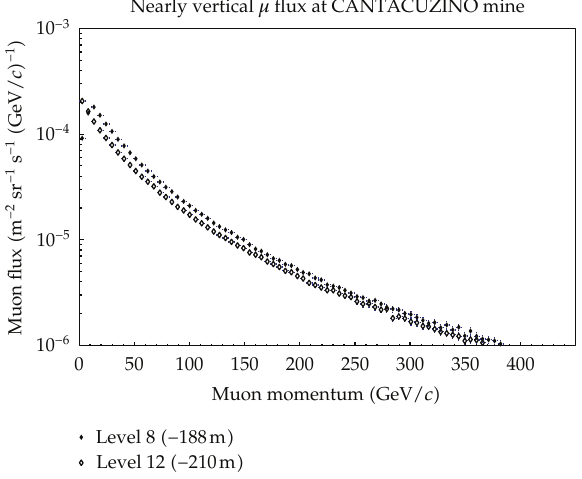
Figure 4: Flux of nearly vertical muons (cid:3) θ ≤ 10 ◦ (cid:4) at two di ff erent levels of CANTACUZINO